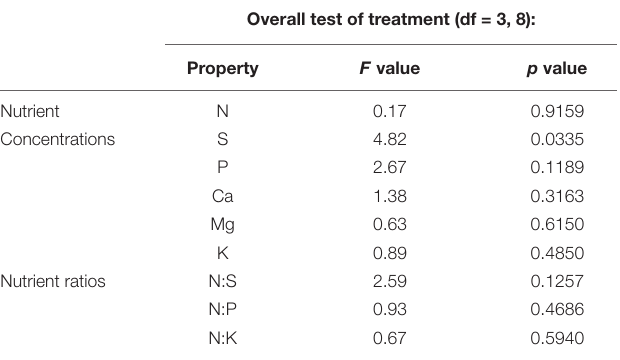
TABLE 4 | ANOVA summary table for lodgepole pine foliar chemistry at year 25. Overall test of treatment (df = 3, 8):